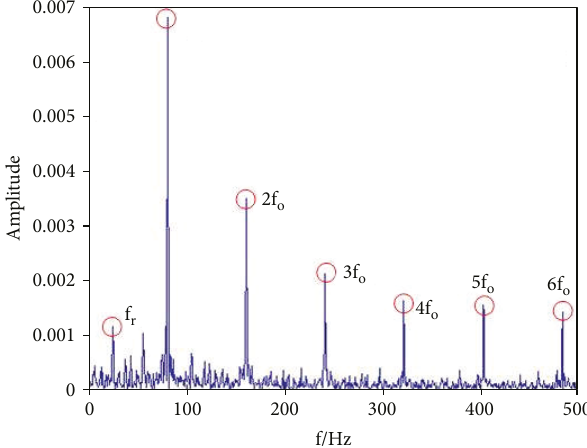
Figure 12: The result provided by the proposed